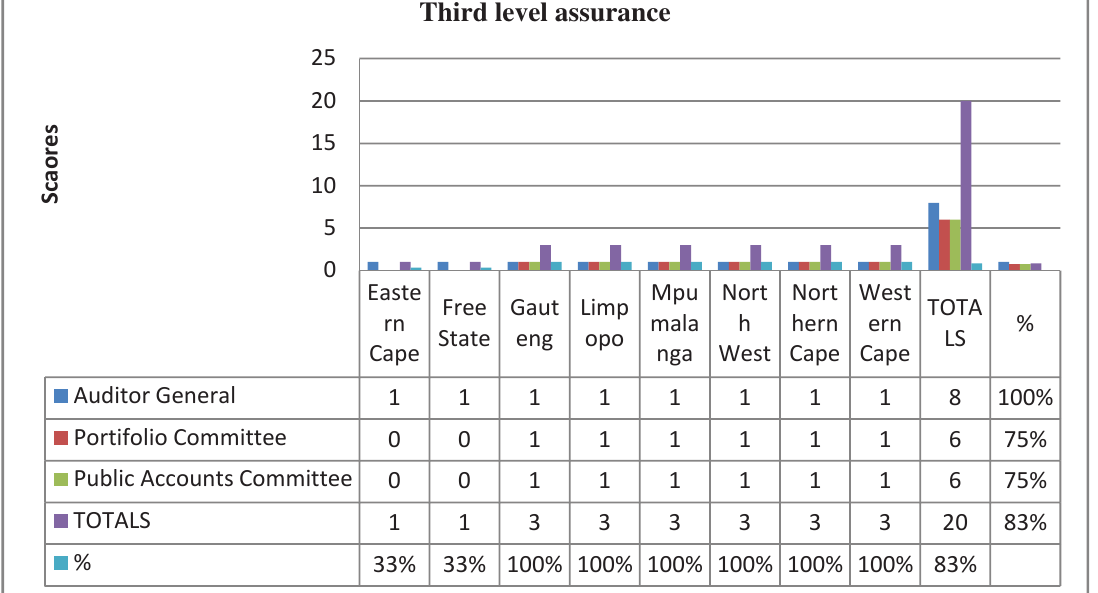
Fig. 2. Third level